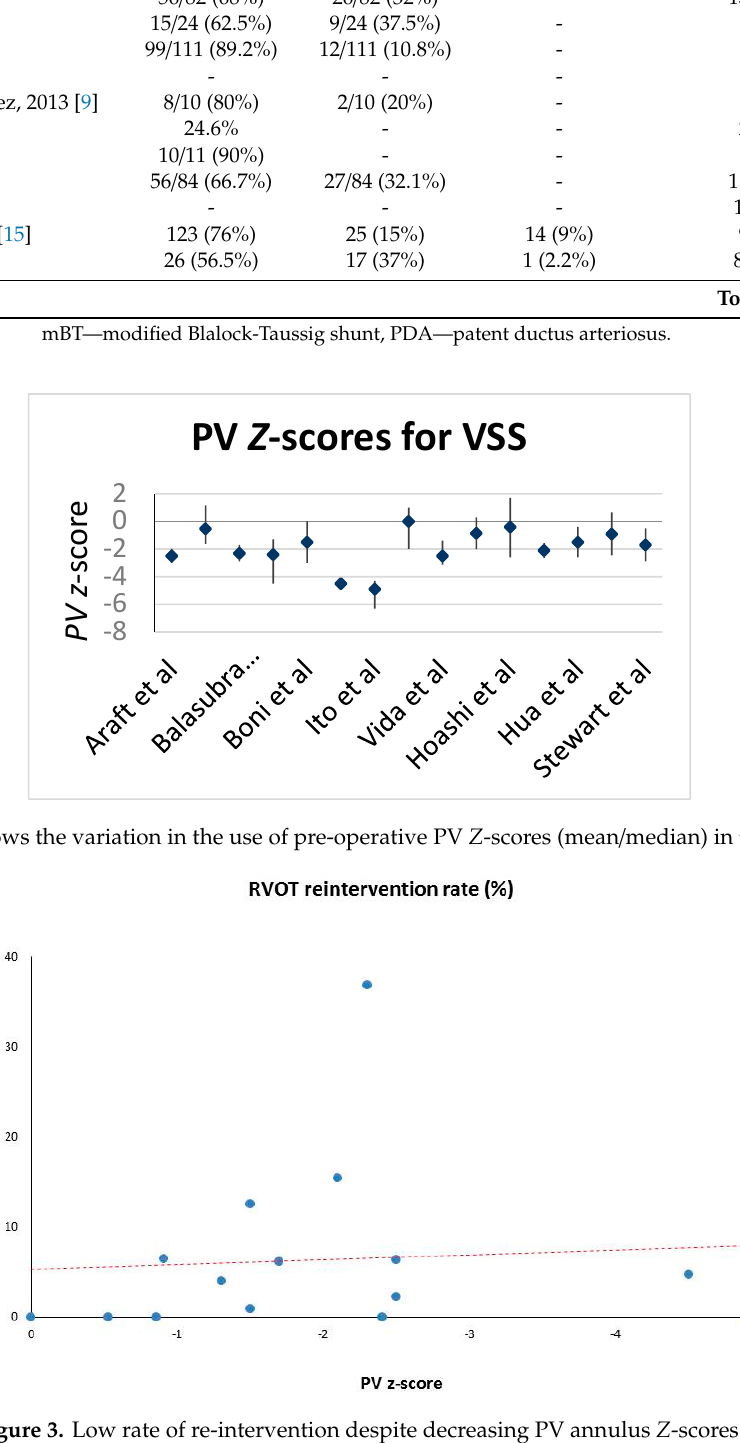
Figure 3. Low rate of re-intervention despite decreasing PV annulus Z -scores.